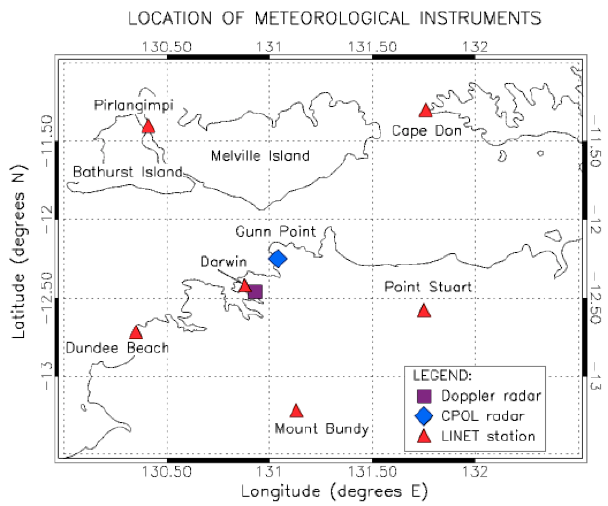
Fig. 1. Location of the two CAWCR radar and six LINET stations involved in the